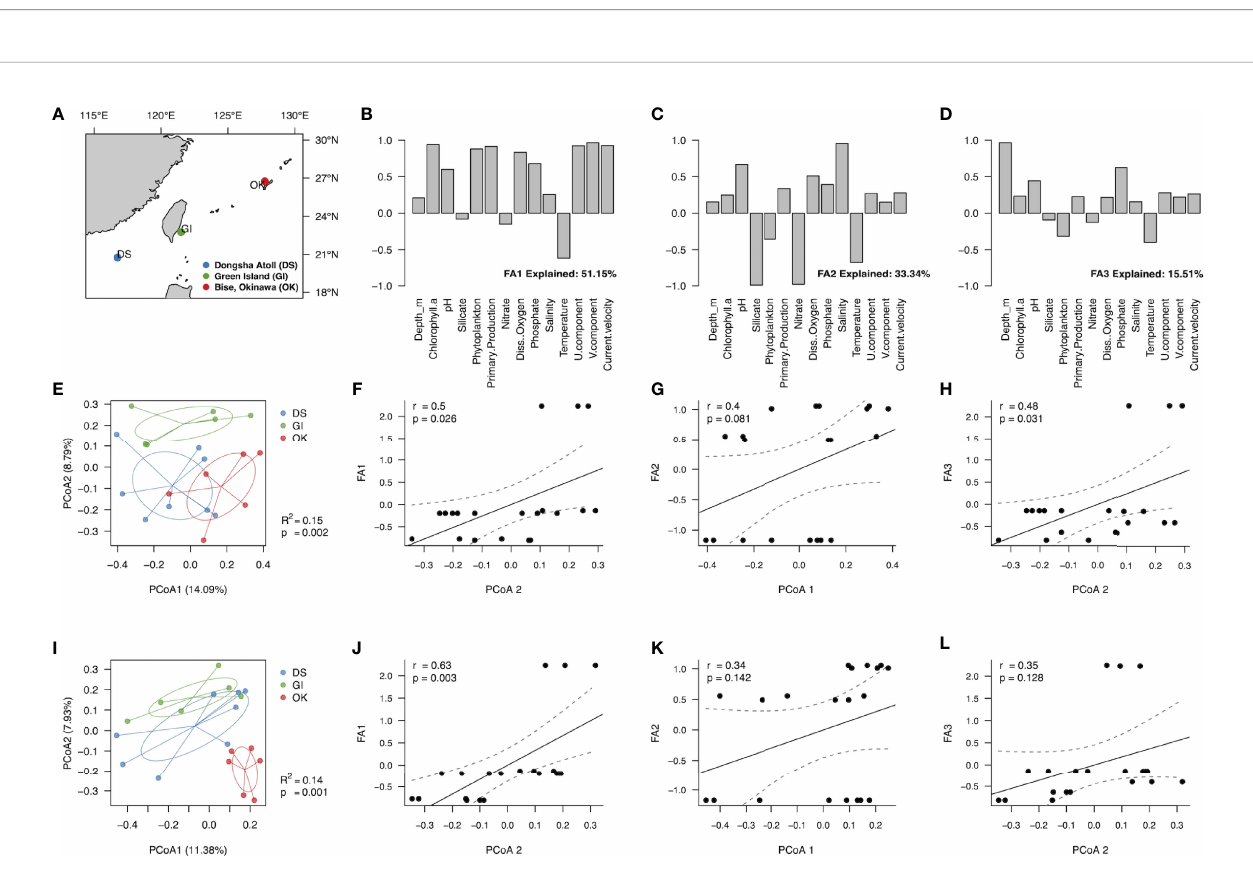
FIGURE 2 | Associations between the Isopora spp. endolithic microbiome and environment factors. (A) Geographical locations of three sampling sites (blue: Dongsha Atoll, DS; green: Green Island, GI; red: Bise-Okinawa, OK) in the western Paci fi c Ocean and South China Sea. (B – D) three components (factor axis, FA) for factor analysis of 14 environmental variables: (B) FA1, the Kuroshio Current and productivity factors; (C) FA2, the inorganic salts factors; (D) FA3, the minor local environmental factors. (E, I) the PCoA ordination of endolithic microbial beta diversity measured by Bray-Curtis dissimilarity using KTU and ASV, respectively. (F – H) and (J – L) the correlation analyses of KTU and ASV, respectively, with three FAs. Dash cubic lines represent the 95% con fi dence intervals of the